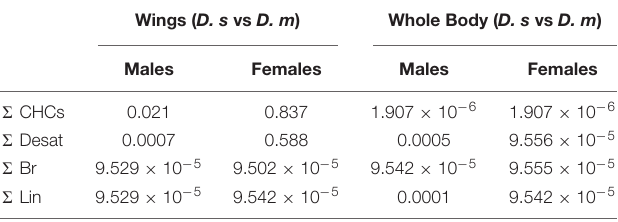
TABLE 3 | p -values of the Wilcoxon test on differences of the wing and whole body total (CHCs), desaturated (Desat), branched (Br), and linear (Lin) CHC amounts between D. suzukii and D. melanogaster males and females presented in Figure 4